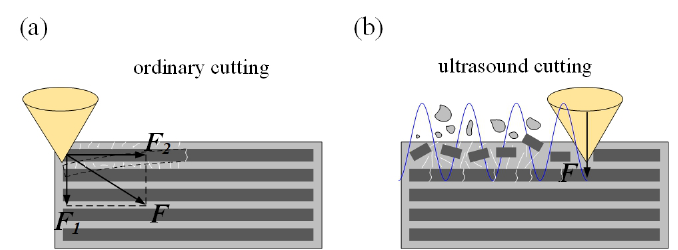
Figure 7. Comparison of material removal mechanisms between ordinary cutting and ultrasound cutting when the fiber orientation angle is 0 ◦ . ( a ) is ordinary cutting and ( b ) is ultrasound cutting.